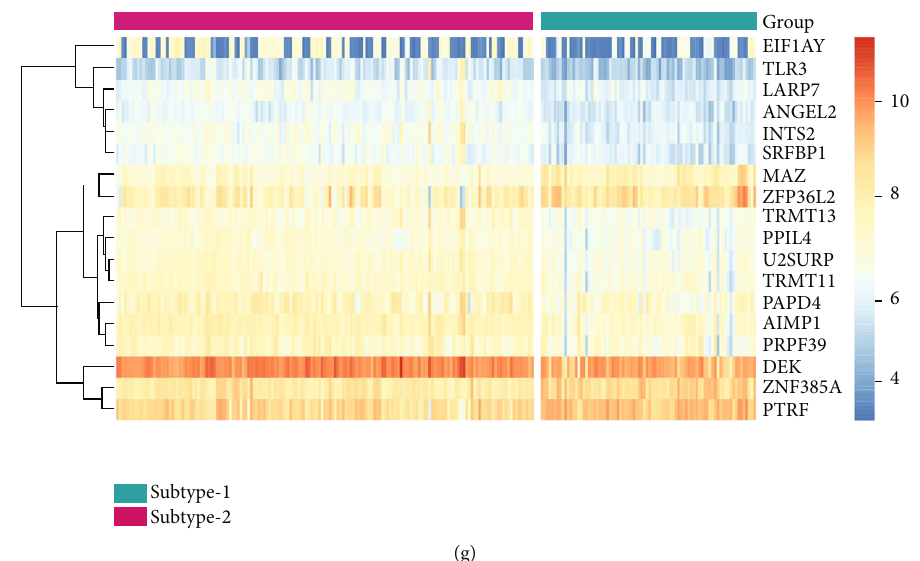
Figure 6: Unsupervised clustering of periodontitis samples based on the RBP expression. (a) Consensus clustering cumulative distribution function (CDF) for k = 2 – 7. (b) Relative change in area under the CDF curve for k = 2 – 7. (c) Heatmap of the matrix of cooccurrence proportions for periodontitis samples. (d) Principle component analysis (PCA) of the two RBP regulatory subtypes. (e) Clinical features of the two RBP regulatory subtypes. (f) Expression of subtype-speci fi c RBPs. The subtype-speci fi c RBPs were the di ff erentially expressed RBPs between the two RBP regulatory subtypes (adjust p value < 0.01, ∣ logFC ∣ >0 : 6 ). (g) Heatmap of the expression of subtype-speci fi c